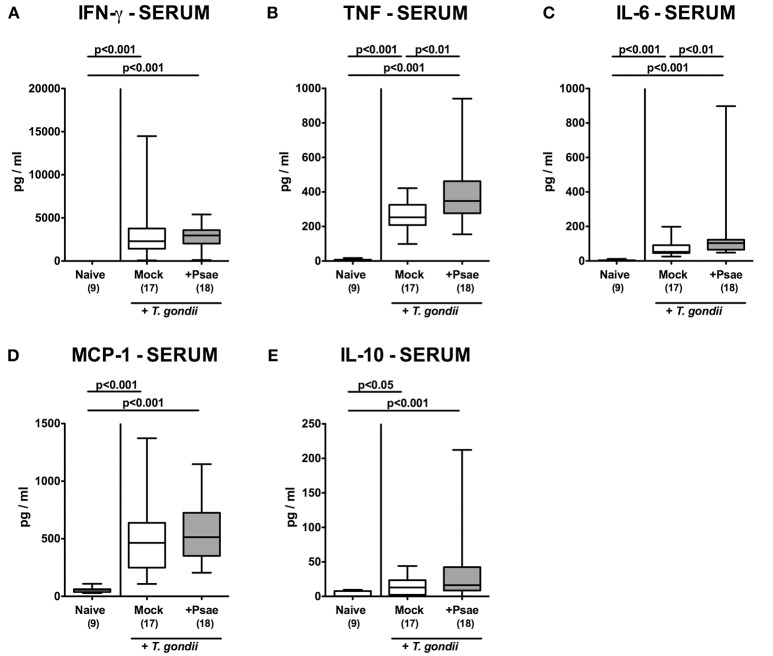
Systemic pro- and anti-inflammatory mediator responses following peroral MDR P. aeruginosa challenge of mice with a human gut microbiota suffering from subacute ileitis. At day 5 following subacute ileitis induction, mice with a human gut microbiota were either perorally challenged with MDR P. aeruginosa (+Psae, dissolved in PBS) or with PBS alone (Mock). Uninfected mice with a human gut microbiota but without ileitis served as control animals (Naive). 96 h following Psae challenge, (A) IFN-γ, (B) TNF, (C) IL-6, (D) MCP-1, and (E) IL-10 concentrations were determined in serum samples. Box plots represent the 75th and 25th percentiles of the median (black bar inside the boxes). The total range and significance levels determined by one-way ANOVA test followed by Tukey post-correction test for multiple comparisons are shown. The total number of analyzed animals are given in parentheses. Data were pooled from four independent experiments.